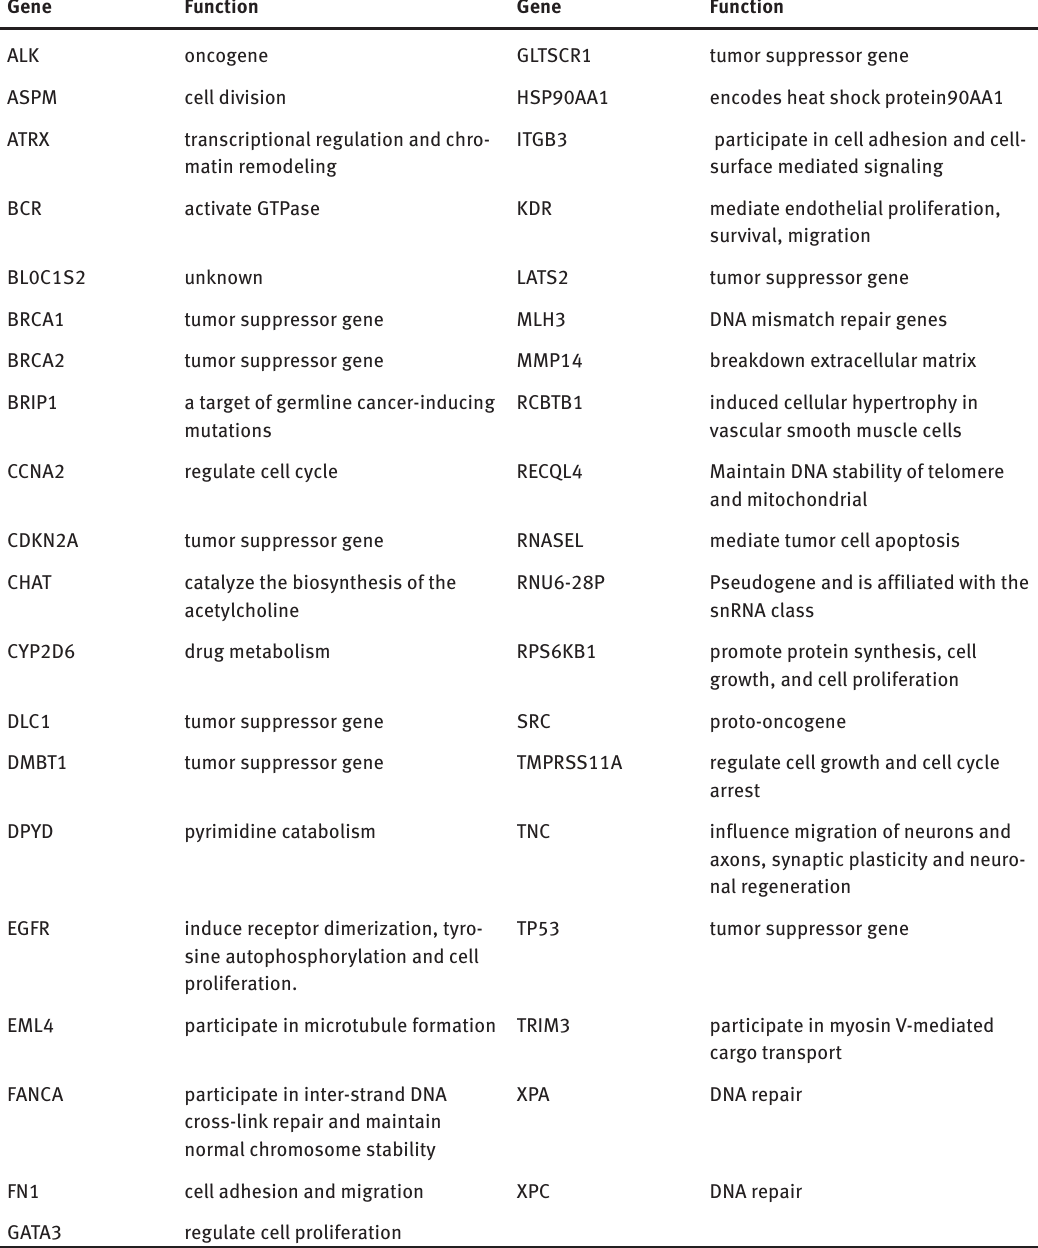
Table 3 : Changes in the expression of mutated genes in bone cancer [45].